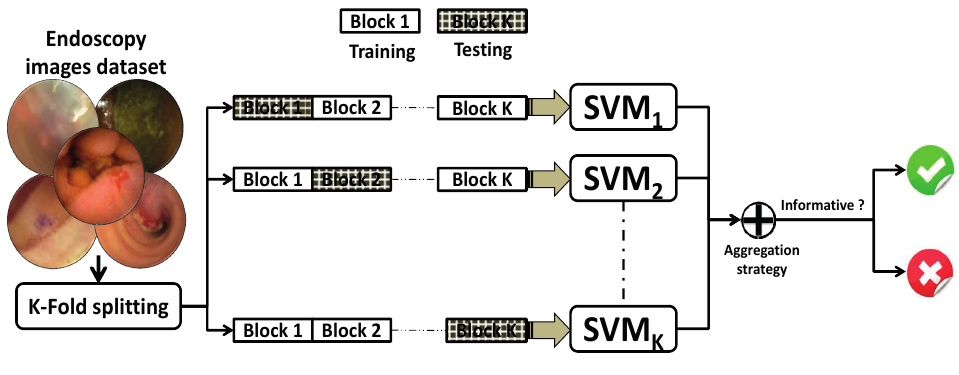
Figure 7. A general framework for training of ensemble SVM